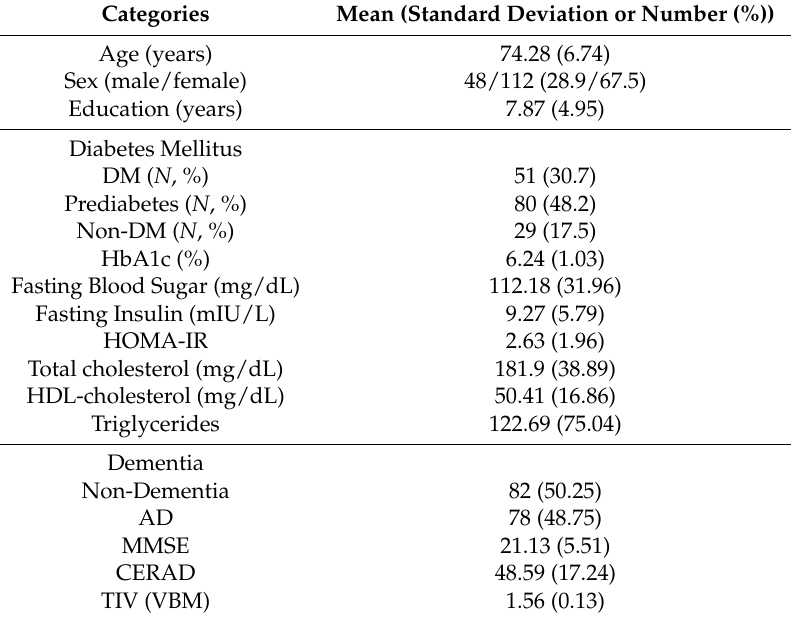
Table 1. Demographic and Clinical